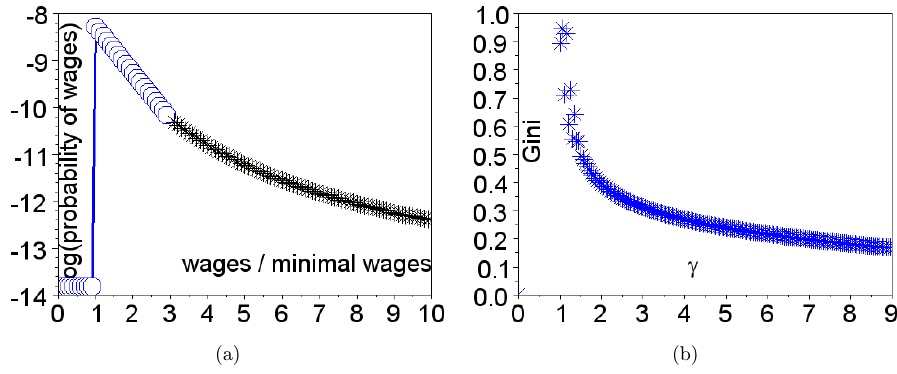
Fig. 3. ( Axes' captions are within the pictures to facilitate the presentation ). (a) A log linear plot of the combined case income density function. The vertical curve is (cid:1) , the light blue curve (circles) is the exponential income curve with (cid:2) ¼ (cid:1) , and the black curve (stars) is the Pareto curve with (cid:5) ¼ 1, (b) the Gini for the combined income density function as a function of the (cid:5) , with (cid:2) ¼ 1 : 4 (cid:1) , where the fair Gini is just where 2 (cid:2) (cid:5)